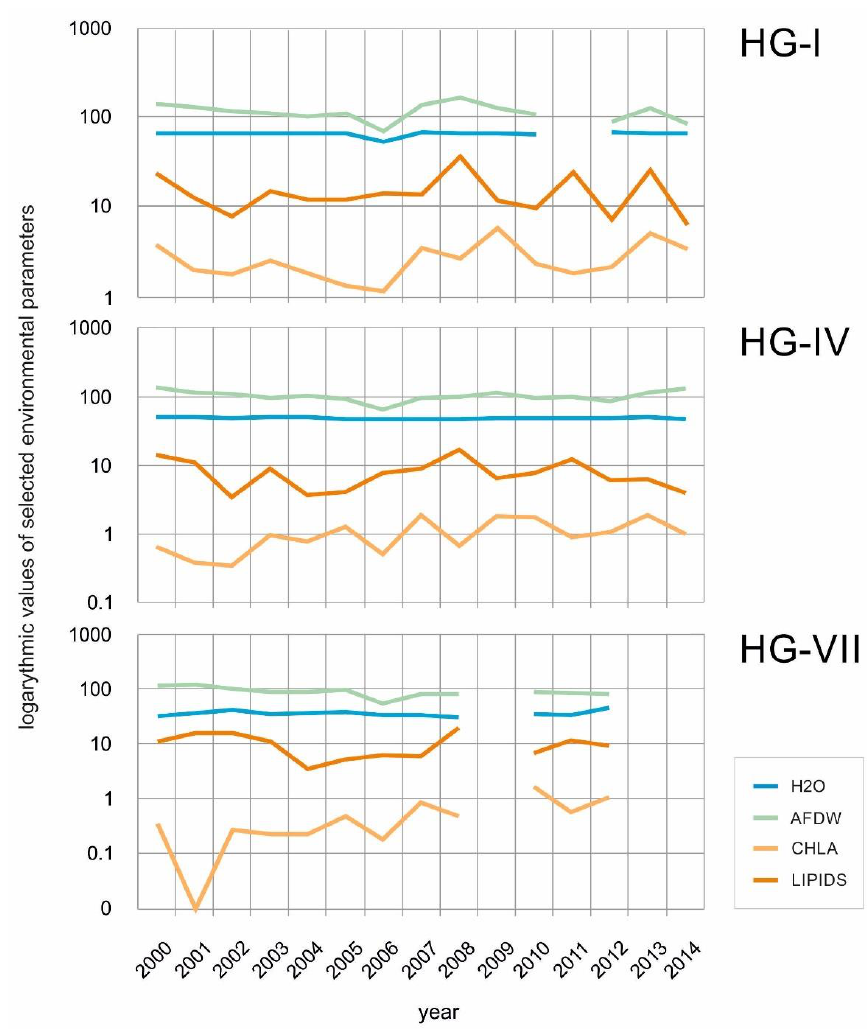
Figure 5. Temporal patterns of selected environmental parameters at HAUSGARTEN sites HG-I (1280 m), HG-IV (2500 m), and HG-VII (4000 m) between 2000 and 2014 (logarithmic data for better comparison in a single graph; H 2 O: water content, AFDW: ash free dry weights, CHLA: chlorophyll a , LIPIDS: phospholipids).